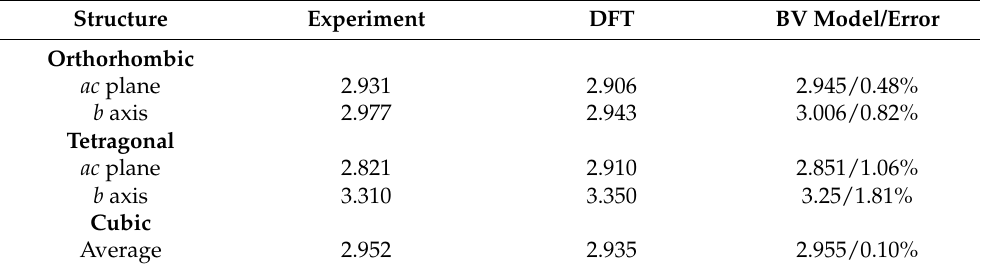
Figure 5. Length of three axes of Pb-Br bond in the CsPbBr 3 structure: ( a ) orthorhombic at 300 K; ( b ) Tetragonal at 380 K; ( c ) cubic at 600 K. Table 3. Pb-Br bond length calculated by DFT, BV model and comparison with experimental results.